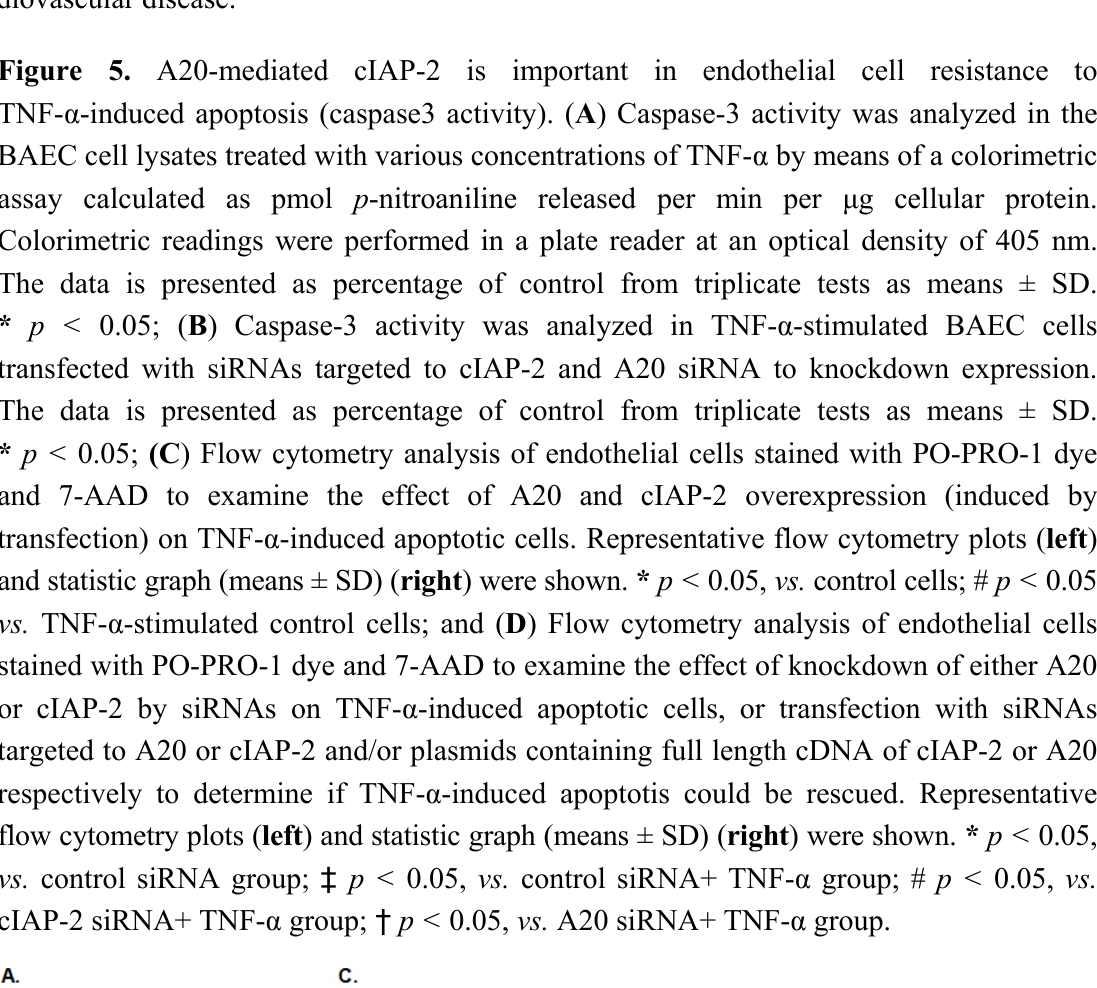
Figure 5. A20-mediated cIAP-2 is important in endothelial cell resistance to TNF- α -induced apoptosis (caspase3 activity). ( A ) Caspase-3 activity was analyzed in the BAEC cell lysates treated with various concentrations of TNF- α by means of a colorimetric assay calculated as pmol p -nitroaniline released per min per μ g cellular protein. Colorimetric readings were performed in a plate reader at an optical density of 405